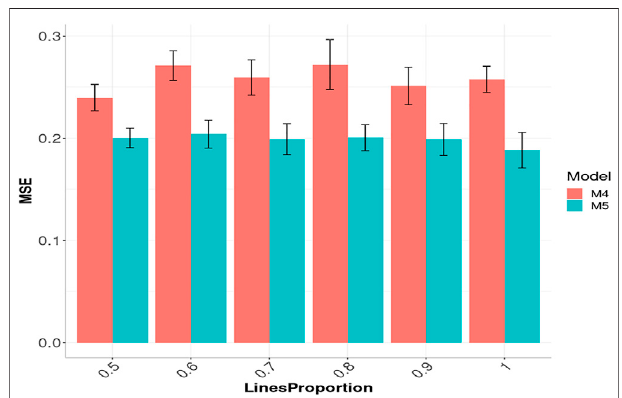
FIGURE 8 | Prediction performance across environments (Global) in Maize data in terms of Mean Square Error (MSE) of models M4 and M5 using the sparse Gaussian kernel with six proportions of compression levels: 0.5, 0.4, 0.3, 0.2, 0.1 and 0, which correspond to using only the following proportions: 0.5, 0.6, 0.7, 0.8, 0.9 and 1 of the original lines (LinesProportion) for computing the sparse kernels, since level of compression = 1 minus